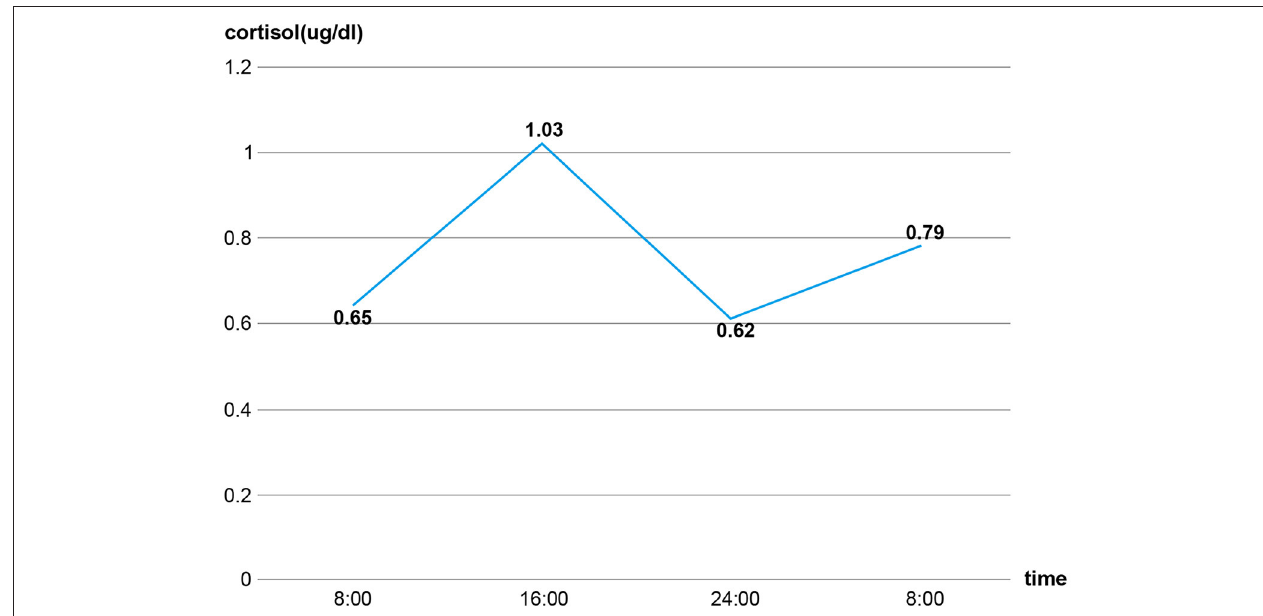
FIGURE 3 | The constantly deficient secretion of